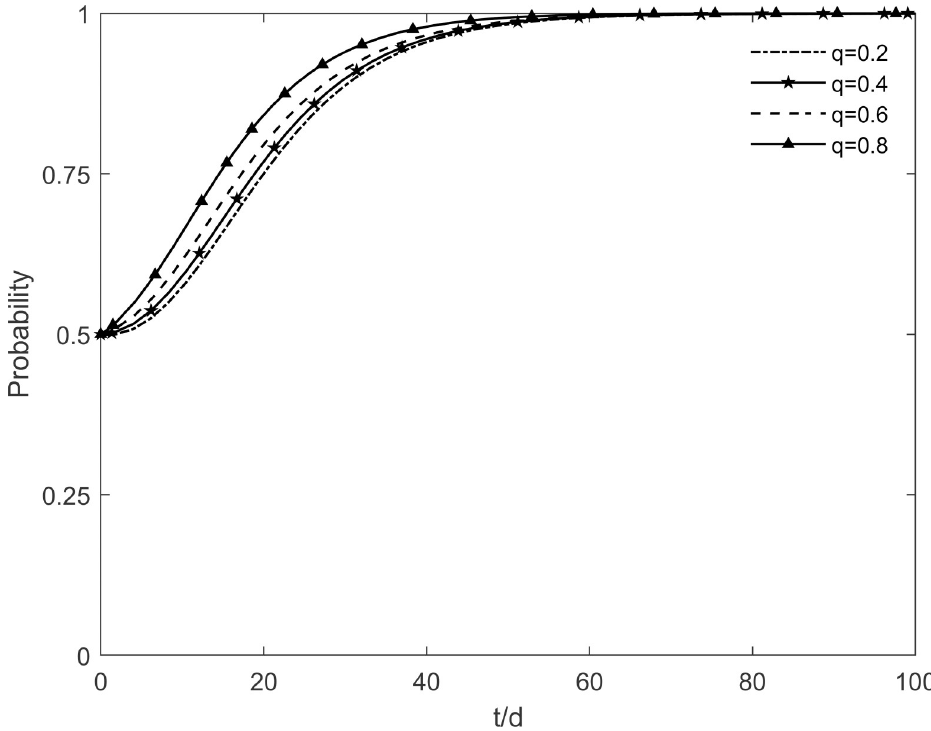
Fig 10. The impact of q on the investment retrofitting enterprises’ strategic choices.